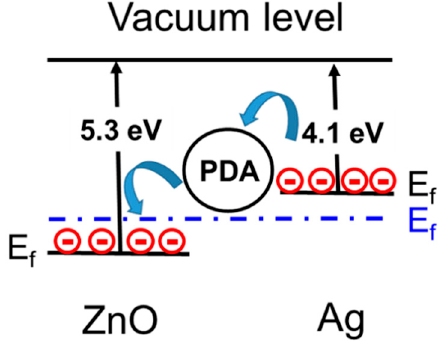
Figure 3. Charge transfer scheme from Ag to ZnO.